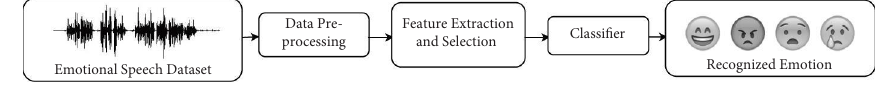
Figure 1: Speech emotion recognition system. Table 1: Summary of some commonly used databases for speech emotion